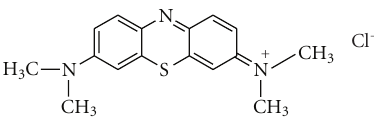
Figure 1: Chemical structure of MB.